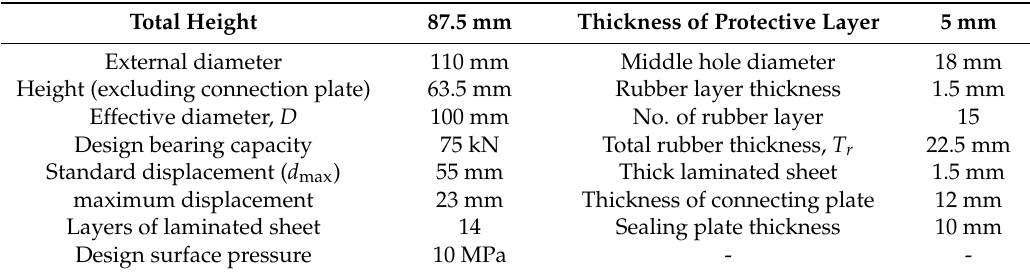
Table 2. The basic parameters of designed rubber